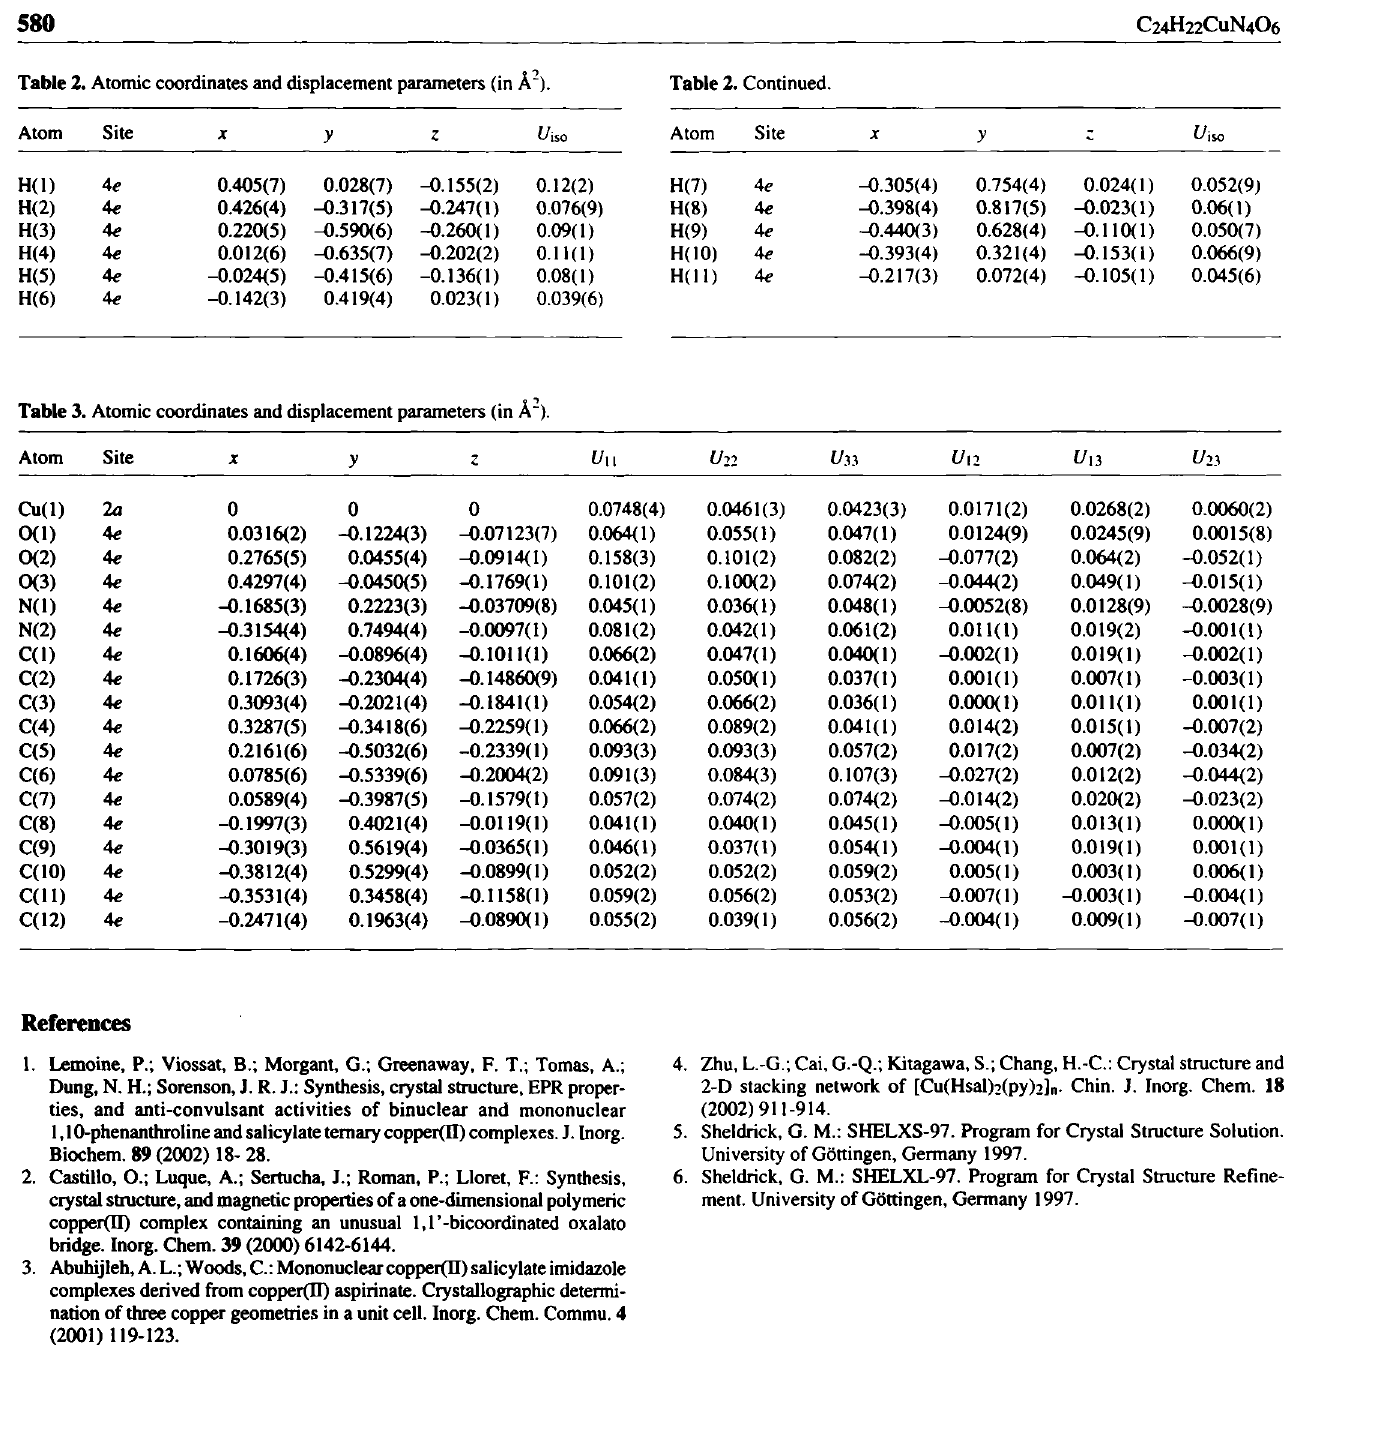
Table 2. Atomic coordinates and displacement parameters (in Â 2 ). Table 2. Continued.